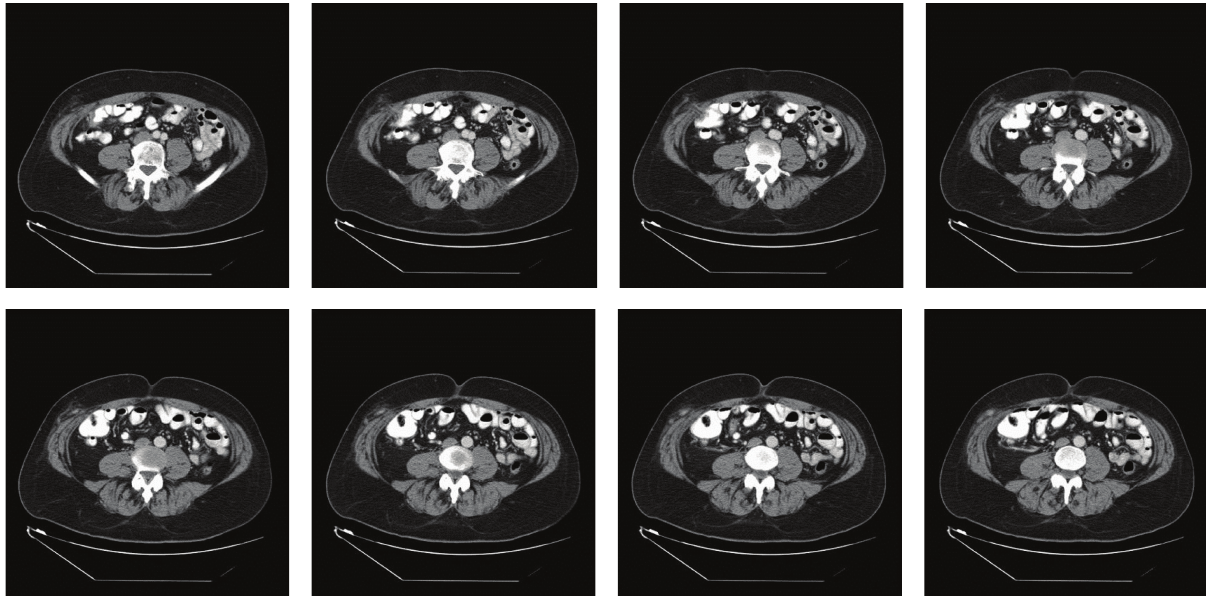
Figure 1: Axial images from a preoperative computed tomography scan demonstrating a right lower quadrant hernia containing fat and the appendix.